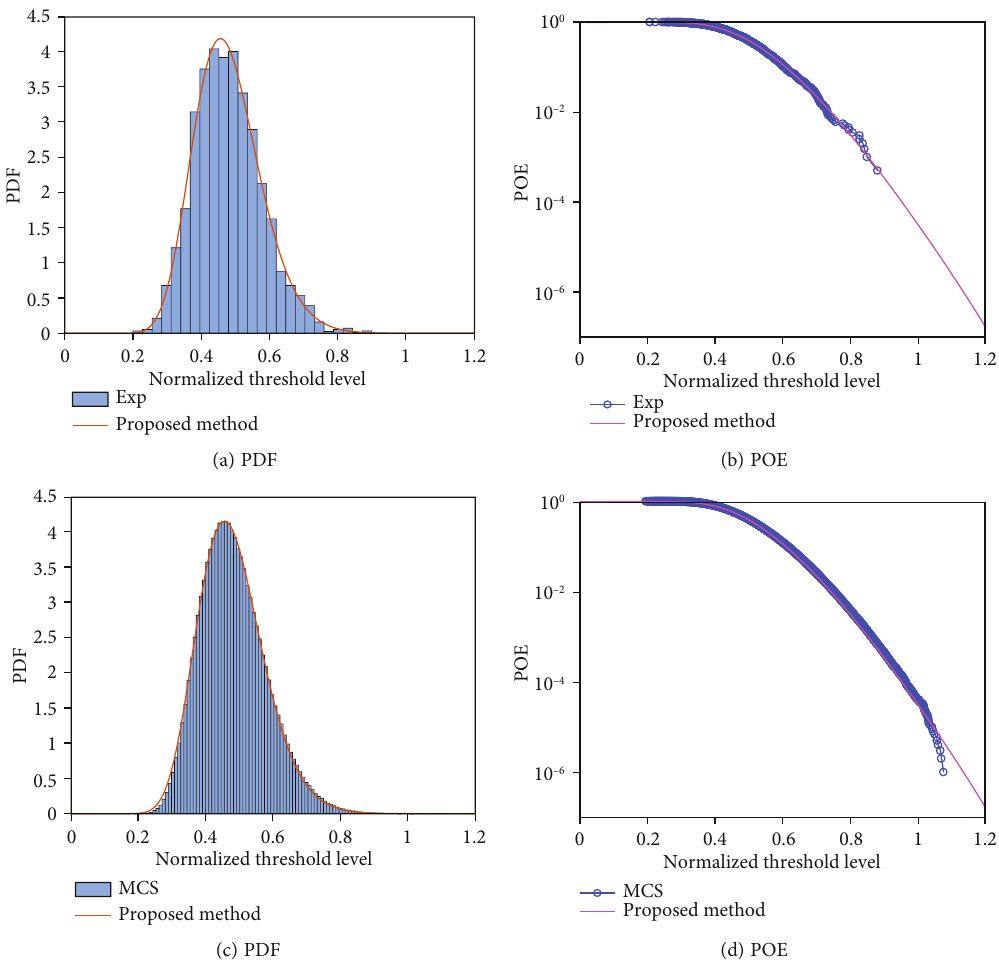
Figure 5: Comparison of histogram, PDF, and POE for m = 3 and N = 2000 . Table 3: The average computational time of the oscillator example